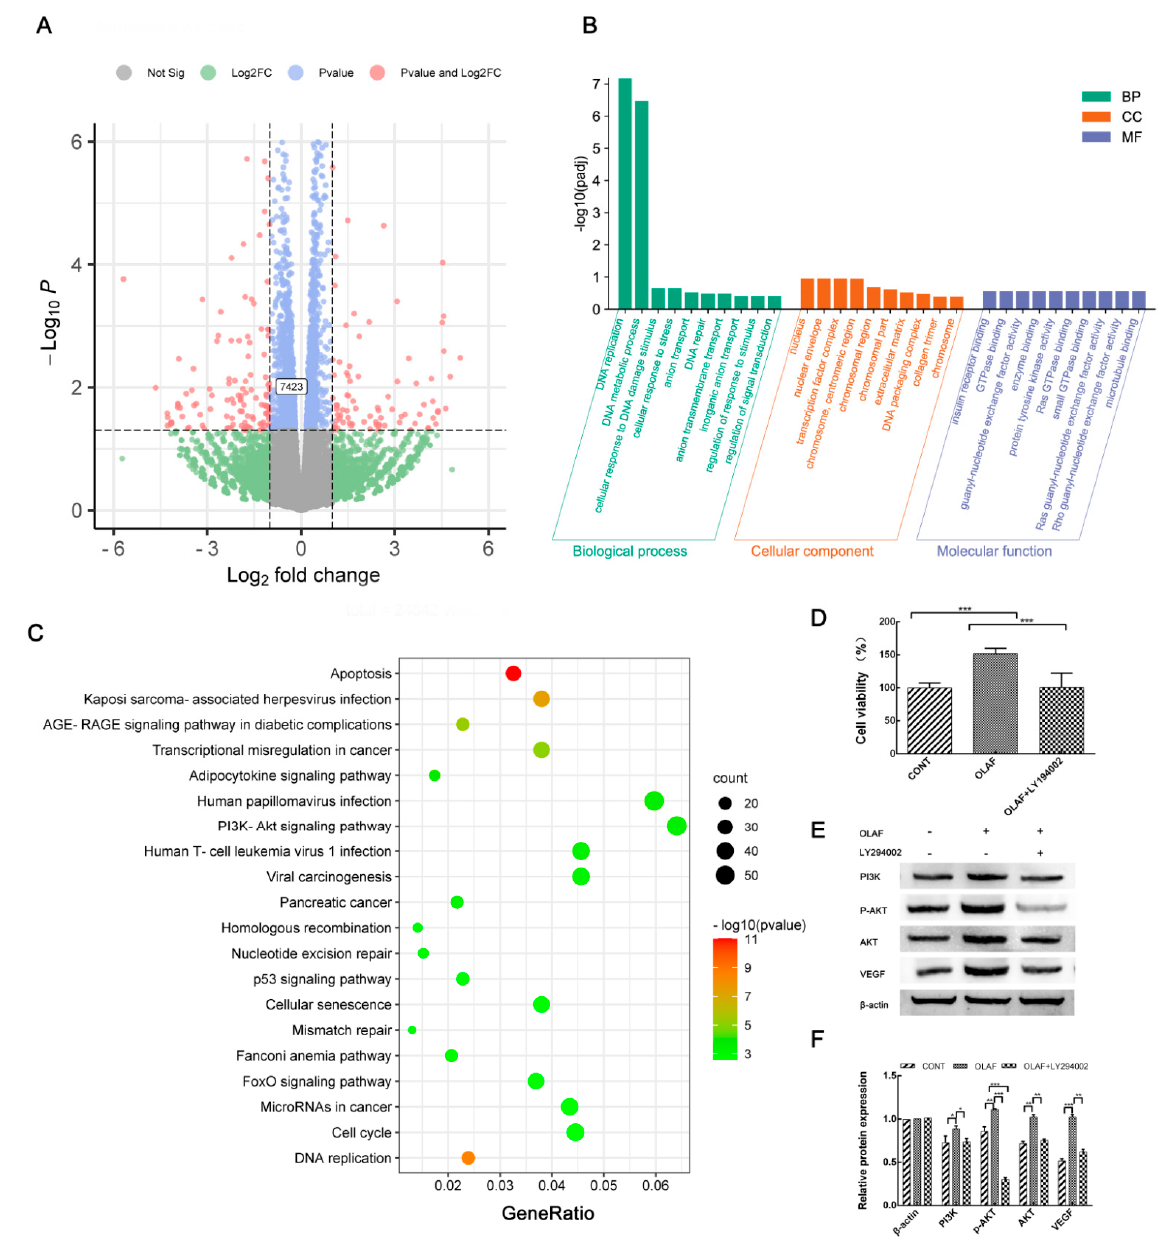
Figure 6. Effects of oleosomes fused with human fibroblast growth factor 1 (OLAF) on the PI3K/AKT pathway in the HUVECs and transcriptome analysis. ( A ) Volcano plot of differentially expressed genes (DEGs) between OLAF-treated and untreated HUVECs. Grey points represent the genes with no significant difference between the two groups. Green points and purple points represent genes with significant differences in the Log2Fold charge or p value between groups, respectively, and orange points are used to indicate the genes with significant differences in the p -value and Log2Fold charge between groups. The unigene 7423 is annotated as VEGF. ( B ) The top 10 GO terms for the biological process (BP), cellular component (CC) and molecular function (MF) in the GO enrichment analysis of the DEGs. ( C ) The top 20 KEGG pathways enriched by DEGs. ( D ) LY294002 changed the promoting effect of OLAF on the viability of HUVECs. ( E , F ) Changes in the expression of PI3K-AKT-pathway-related proteins in HUVECs stimulated by OLAF with or without LY294002, and the corresponding statistical analysis results. * p < 0.05, ** p < 0.01, *** p < 0.001. Mean ± SD was employed to display all the obtained data (n =